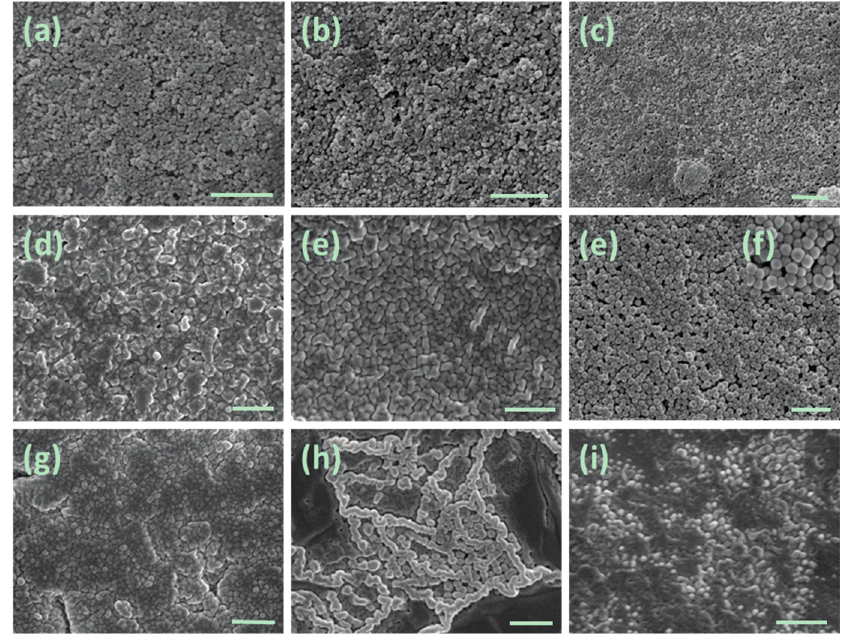
Figure 4. SEM images of BIm-based nanogels. (( a ) [C 6 VIm]Br:EGDMA = 10:1; ( b ) [C 8 VIm]Br:EGDMA = 10:1; ( c ) [C 12 VIm]Br:EGDMA = 10:1; ( d ) [C 6 VIm]Br:EGDMA = 15:1; ( e ) [C 6 VIm]Br:EGDMA = 5:1; ( f ) [C 6 VIm]Br:EGDMA = 3:1; ( g ) [C 6 VIm]Br:DVB =